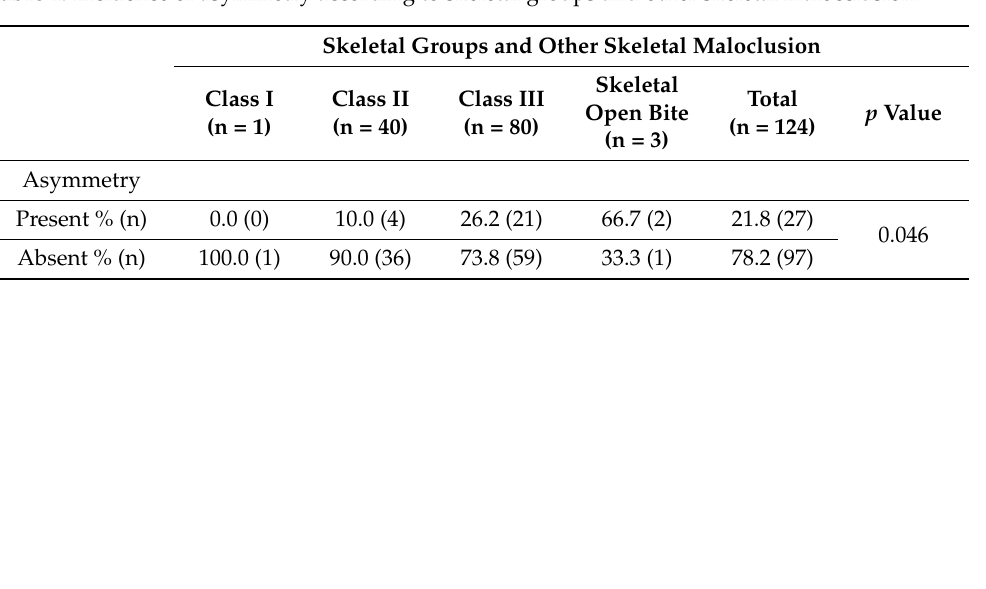
Table 4. Incidence of asymmetry according to skeletal groups and other skeletal